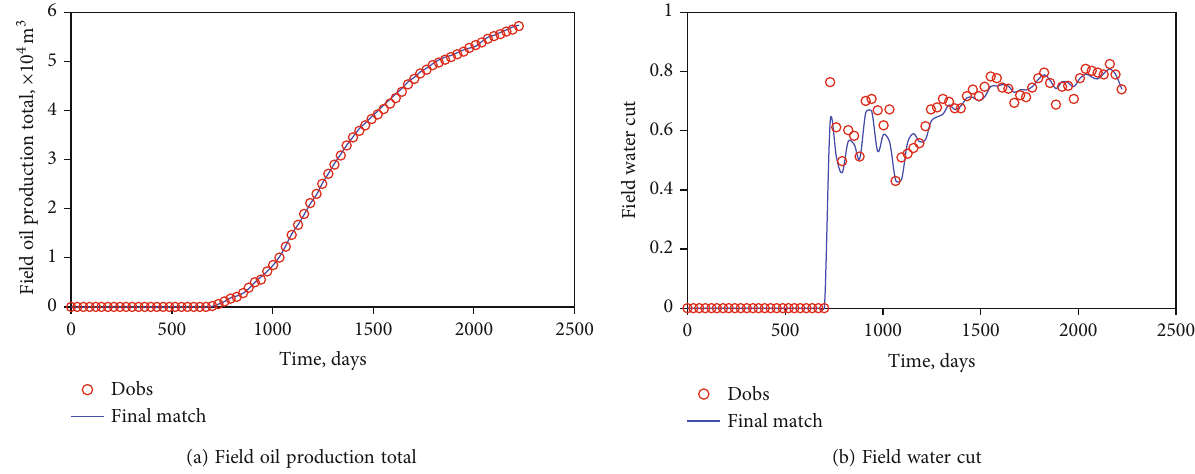
Figure 12: History matching results of block production